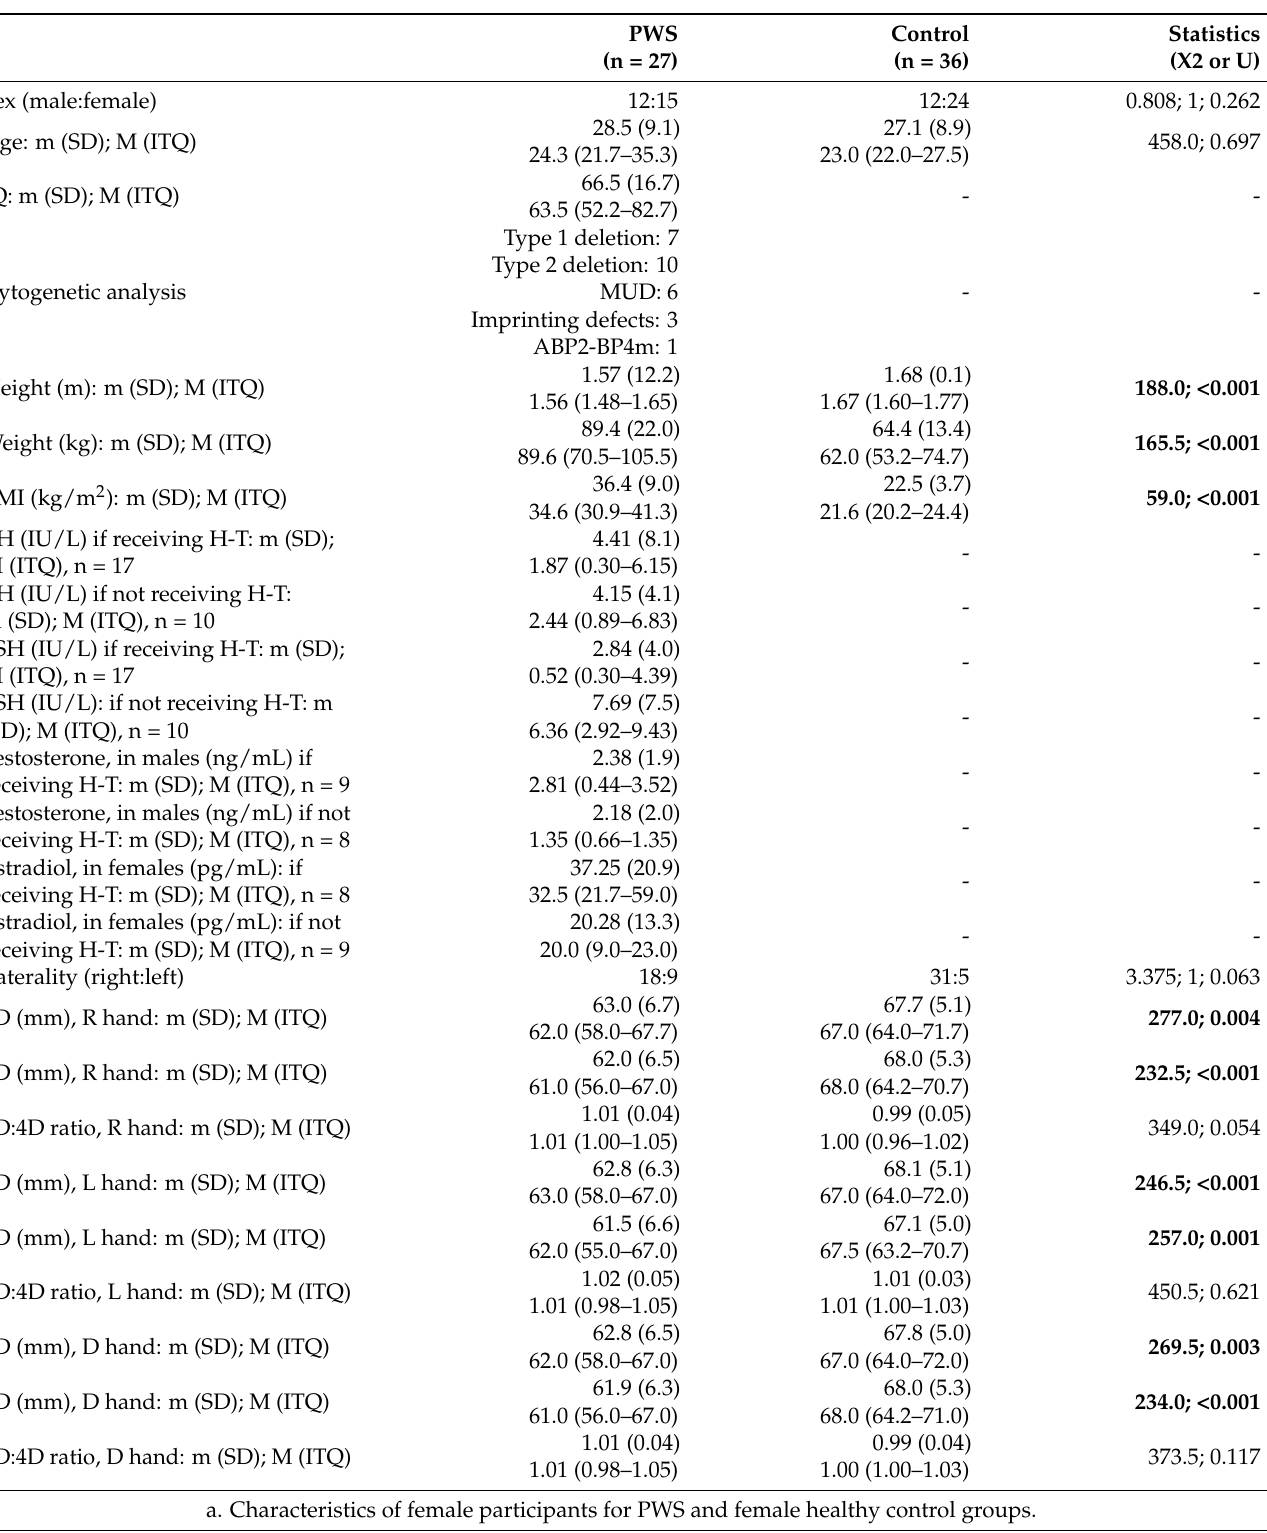
Table 1. Characteristics of participants for PWS and healthy control groups (both sexes).